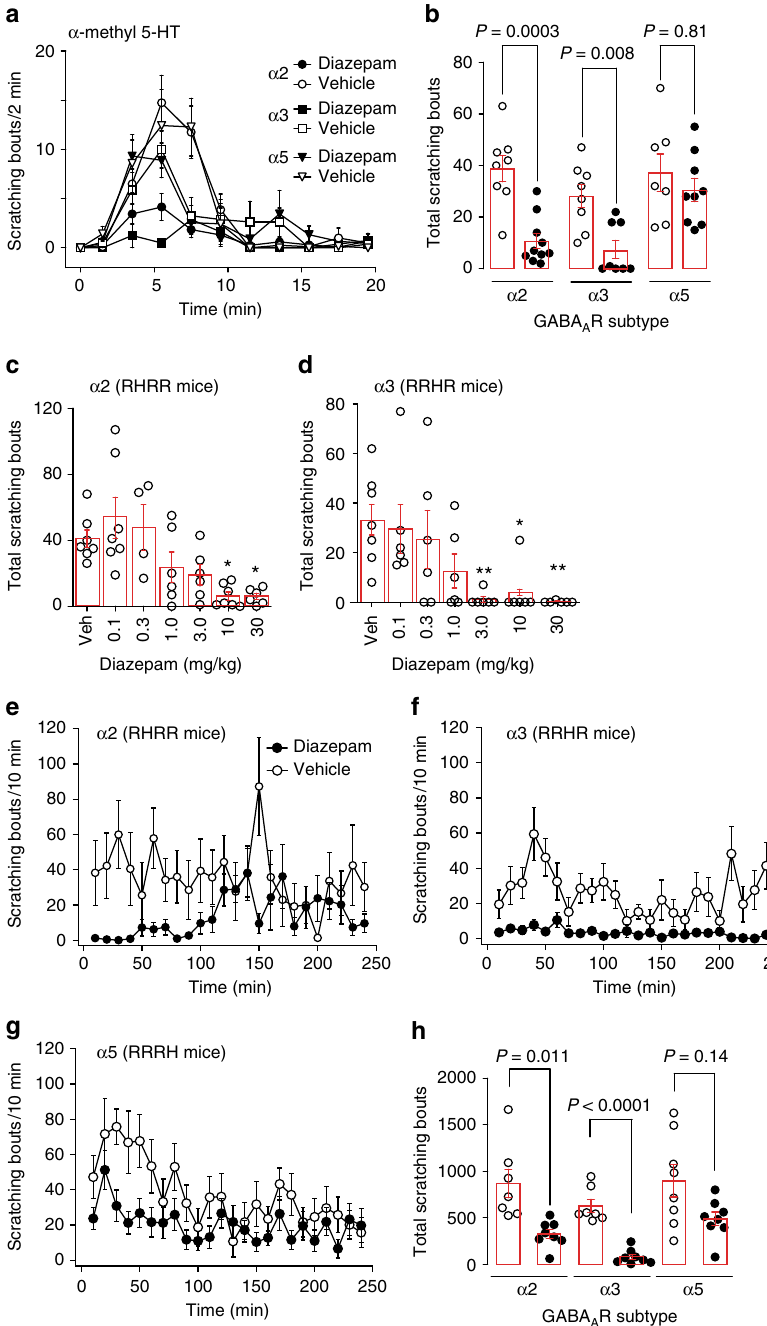
Fig. 3 Antipruritic effects of GABA A R modulation in GABA A R triple point mutated mice. a – d Suppression of acute itch by α 2, α 3, and α 5GABA A Rs activation (diazepam 10 mg kg − 1 , p.o., given 60 min prior to pruritogen injection) in three lines of triple GABA A R point mutated mice ( α 2 [RHRR mice], α 3 [RRHR], or α 5 [RRRH]). a Number of scratching bouts over time after diazepam injection. b Comparisons were made for diazepam ( fi lled circles) versus vehicle (open circles) for the three genotypes. P values were obtained from unpaired two-sided t-tests corrected for three independent comparisons. n = 8 and 10 ( α 2, vehicle, diazepam); n = 8 and 8 ( α 3, vehicle, diazepam); n = 7 and 9 ( α 5, vehicle, diazepam). c Dose-dependence of the antipruritic effects of diazepam in RHRR mice (only α 2GABA A Rs sensitive to diazepam). ANOVA followed by Dunnett ’ s post hoc test F(6,36) = 6.02; * P < 0.05; ** P < 0.01, n = 7, 7, 4, 6, 6, 7, 5, for vehicle, and 0.1, 0.3, 1.0, 3.0, 10, and 30 mg kg − 1 . d Same as c but RRHR mice (only α 3GABA A Rs sensitive to diazepam). ANOVA followed by Dunnett ’ s post hoc test F(6,37) = 4.42; * P < 0.05; ** P < 0.01, n = 7 (vehicle) and 6 for all other groups. e – h Suppression of chronic itch. Antipruritic effects of α 2, α 3, and α 5GABA A Rs in the oxazolone model of atopic-like dermatitis. Mice were sensitized to oxazolone over 17 days and treated with diazepam (10 mg kg − 1 , i.p.) or vehicle on day 18. Scratching bouts were counted for 6 h starting 15 min after drug or vehicle administration. e – g Number of scratching bouts plotted versus time after drug or vehicle administration. h P values obtained from unpaired two-sided t -tests for the three genotypes, corrected for three independent comparisons. Unpaired two-sided t -tests, n = 7 and 8 ( α 2, vehicle, diazepam); n = 7, 8 ( α 3, vehicle, diazepam); n = 8, 8 ( α 5, vehicle, diazepam). Error bars indicate